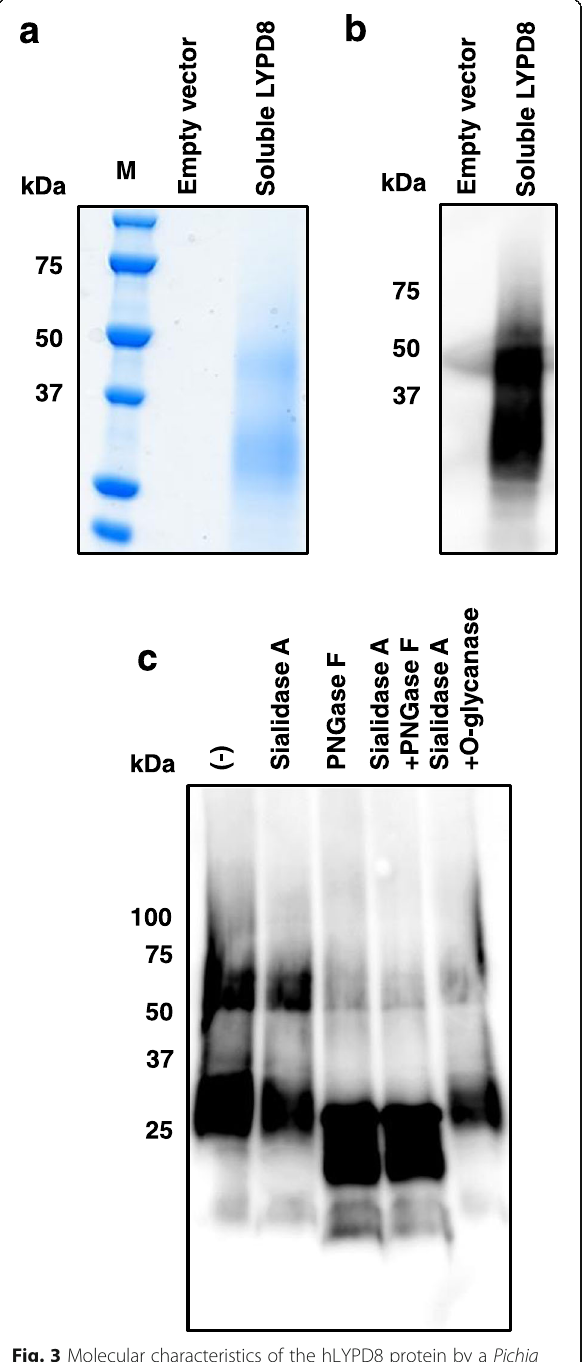
Fig. 3 Molecular characteristics of the hLYPD8 protein by a Pichia pastoris expression system. a, b Protein samples purified from the culture media of Pichia pastoris transfected with empty vector or soluble hLYPD8 expression vector were separated by SDS-PAGE followed by Coomassie staining ( a ) and anti-FLAG immunoblotting ( b ). c Immunoblotting for recombinant soluble hLYPD8 protein untreated or treated with sialidase A, PNGase F, or O